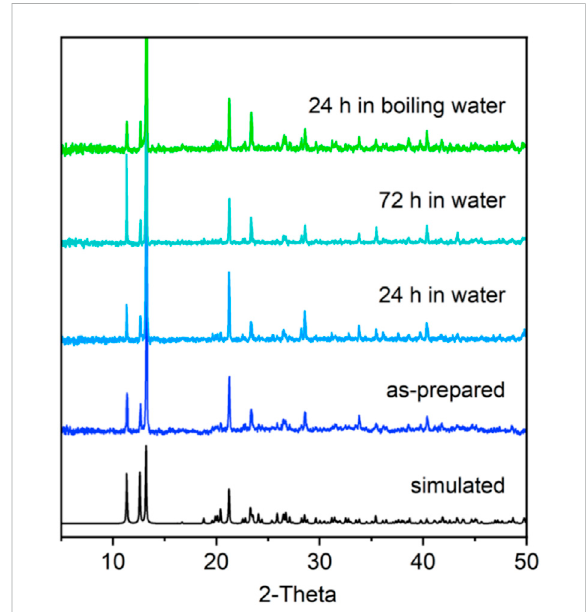
FIGURE 3 PXRD patterns of synthesized Dy-CP (5 – 50 ° ) sample and those were treated with water for several days.